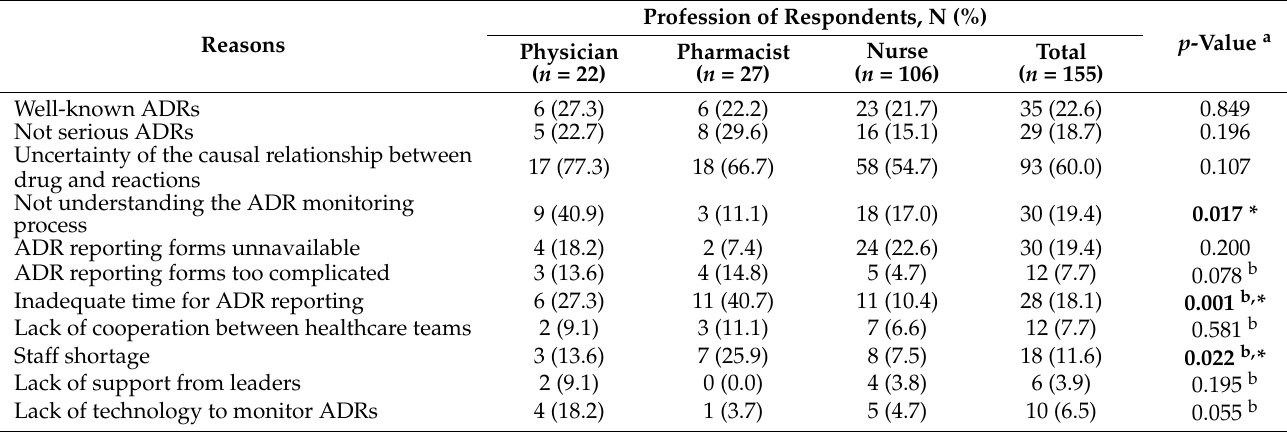
Table 3. Barriers to ADR reporting experienced by